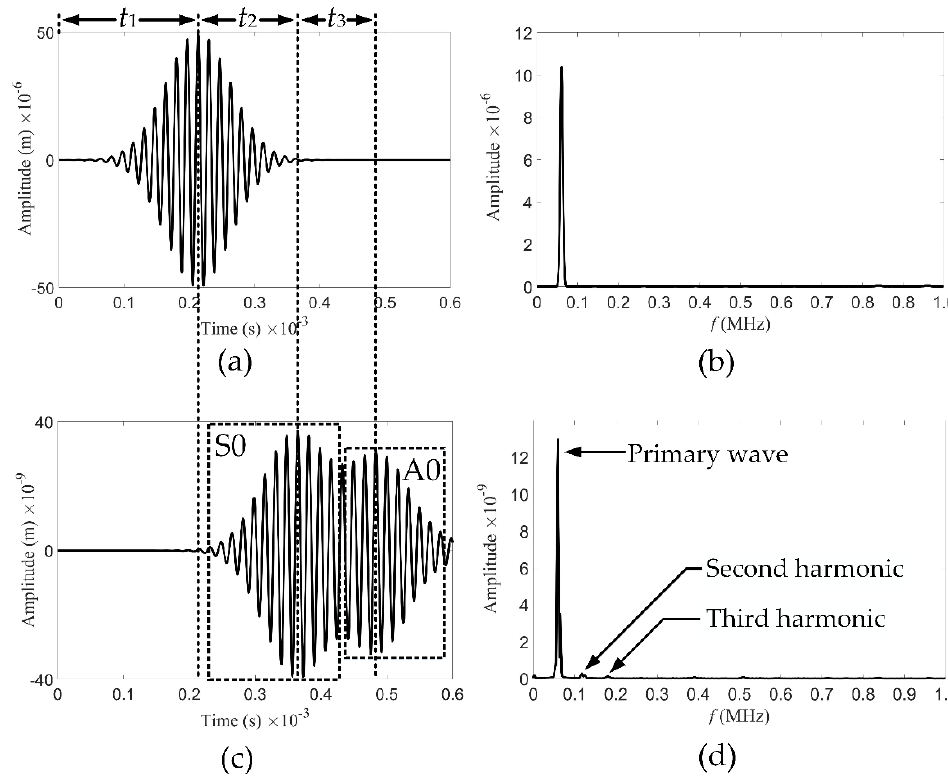
Figure 5. A sensor receives the signals actuated by itself and the signals actuated by the opposite sensor. ( a ) Time domain signals actuated by itself. ( b ) Frequency spectrum corresponding to ( a ). ( c ) Time domain signals actuated by the opposite sensor. ( d ) Frequency spectrum corresponding to ( c ). The central frequency of the excitation signals is 60 kHz.